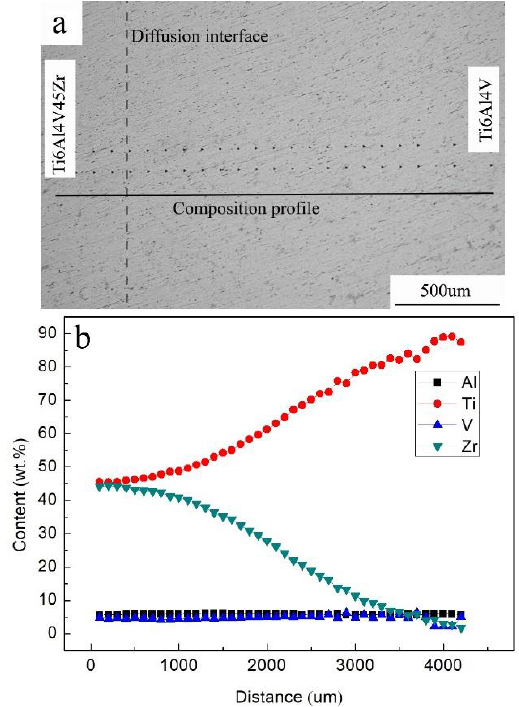
Figure 3. ( a ) Optical image of hardness indentation grid at the Ti6Al4V–Ti6Al4V45Zr diffusion multiple; ( b ) variation in the composition as a function of distance for the Ti6Al4V–Ti6Al4V45Zr diffusion multiple.